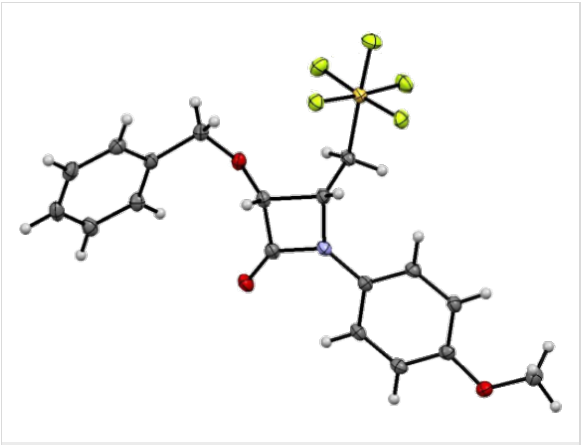
Figure 1: The 1,2- lk stereochemistry of 7a as determined by single crystal X-ray diffraction. Thermal ellipsoids are set at 50% probability.